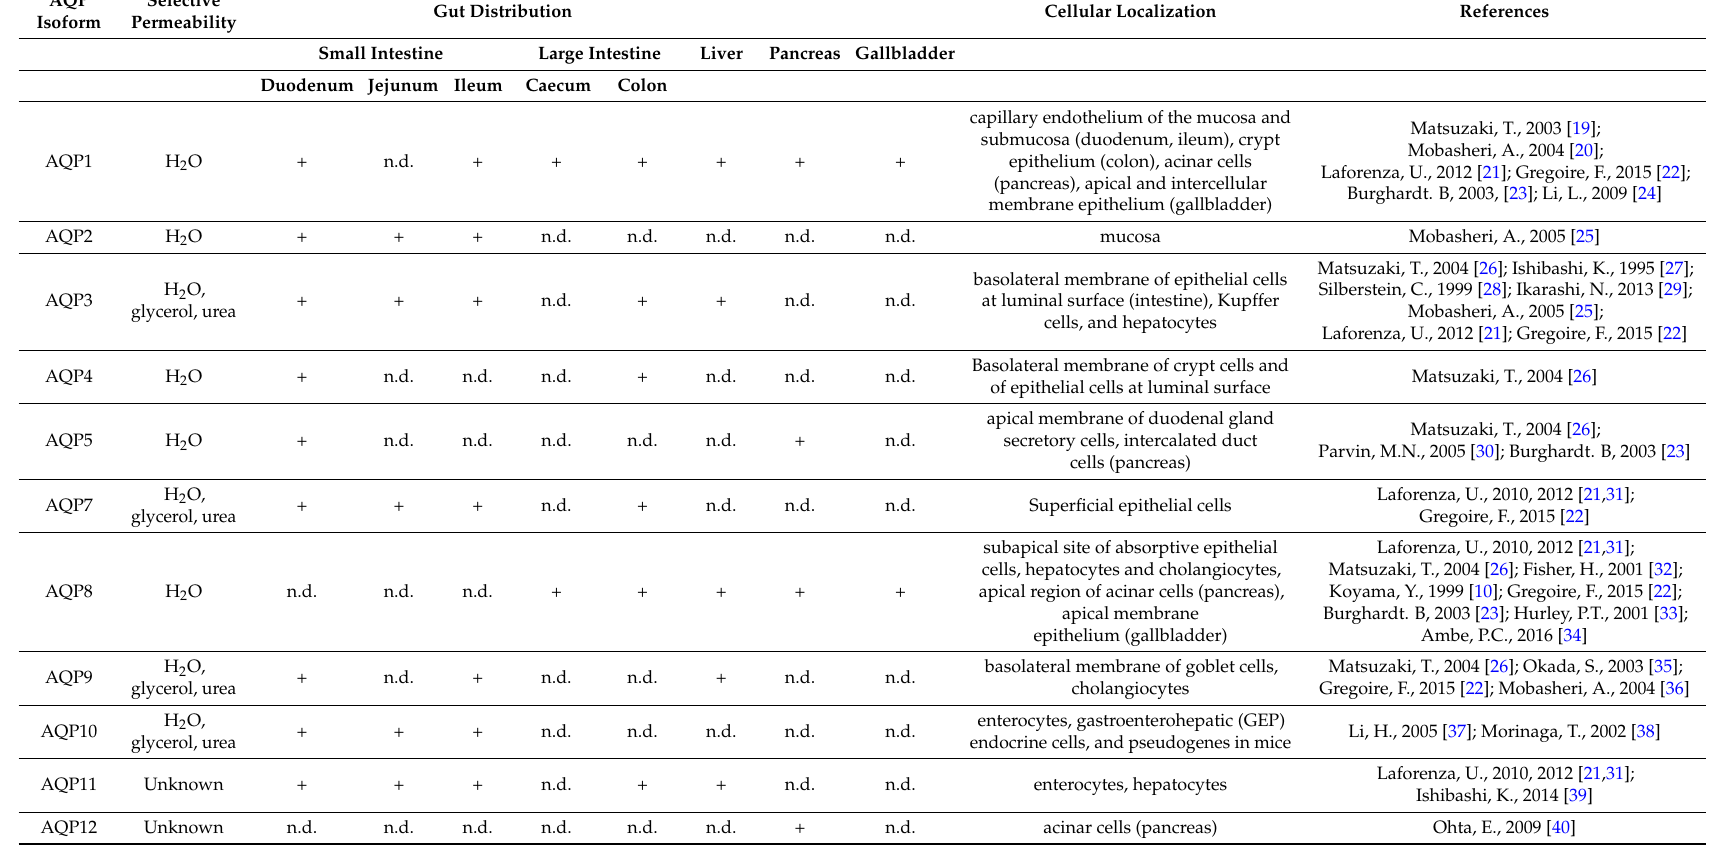
Table 1. Gut distribution, selective permeability, and tissue localization of AQPs in human and murine tissues. AQP